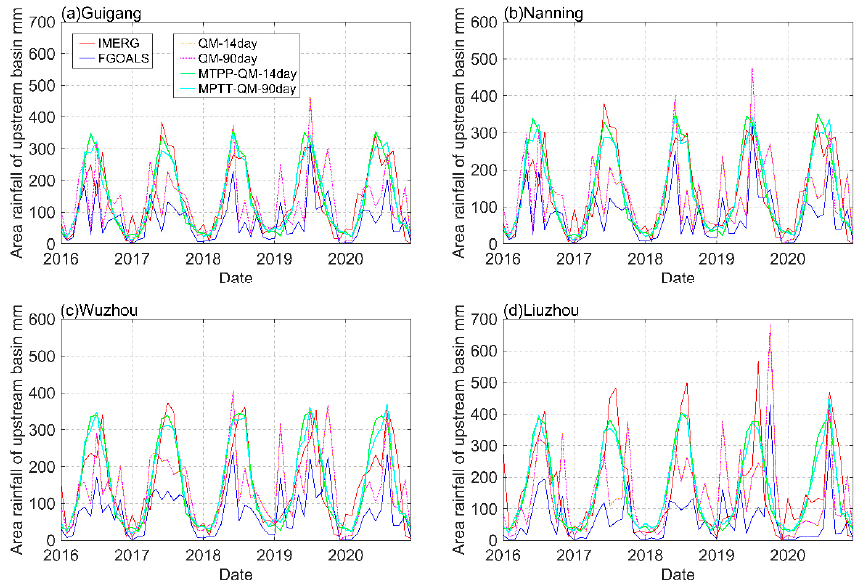
Figure 10. Area rainfall of the upstream basin intensity–time curve of the PRB on the monthly scale from 2016 to 2020: ( a – d ) represent the Guigang, Nanning, Wuzhou, and Liuzhou stations, respectively (unit: mm).